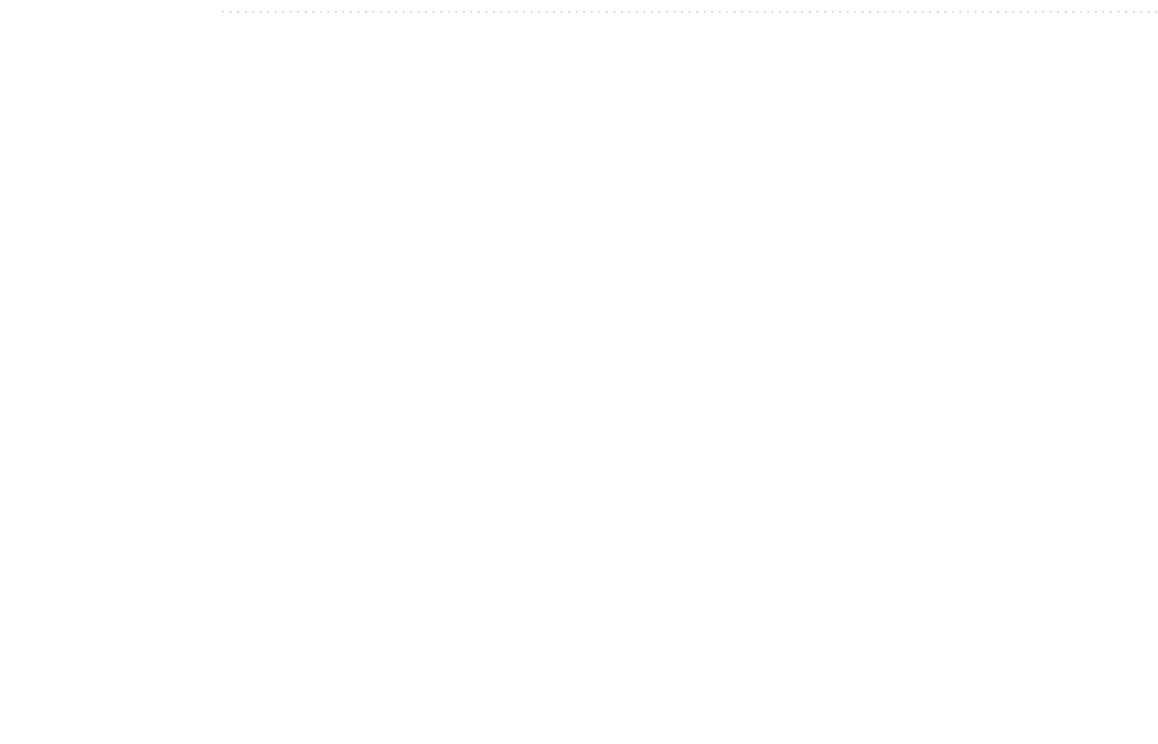
Figure 12. Axle box vertical vibration acceleration, at (a-b) uniform speed, (c-d) coasting